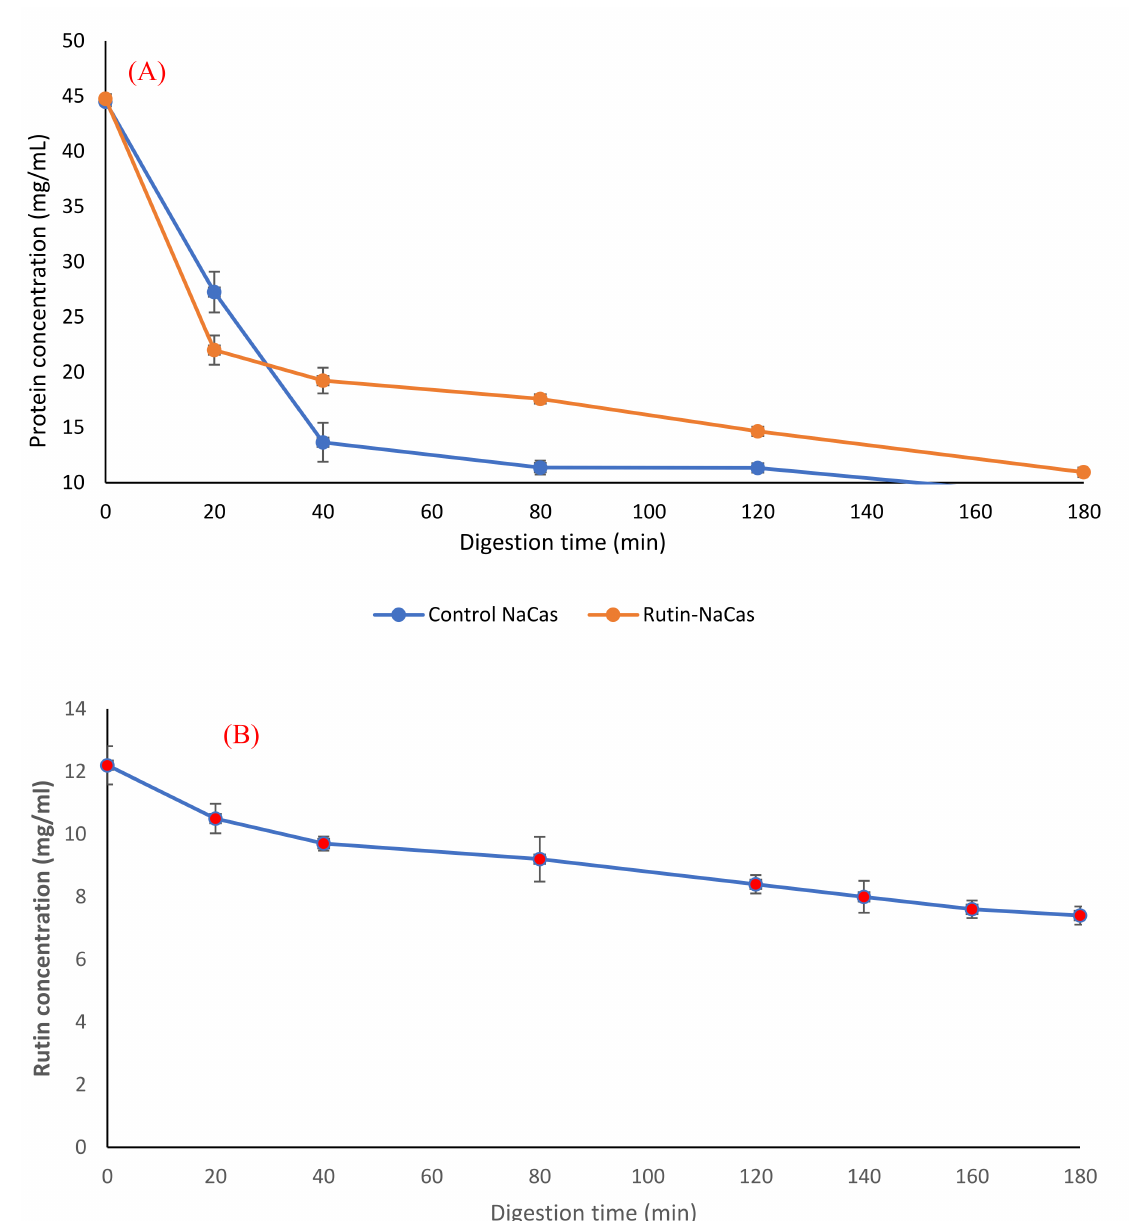
Figure 6. Protein release behaviour ( A ) and rutin release behaviour ( B ) of the rutin–NaCas nanocom- plexes during the simulated gastric